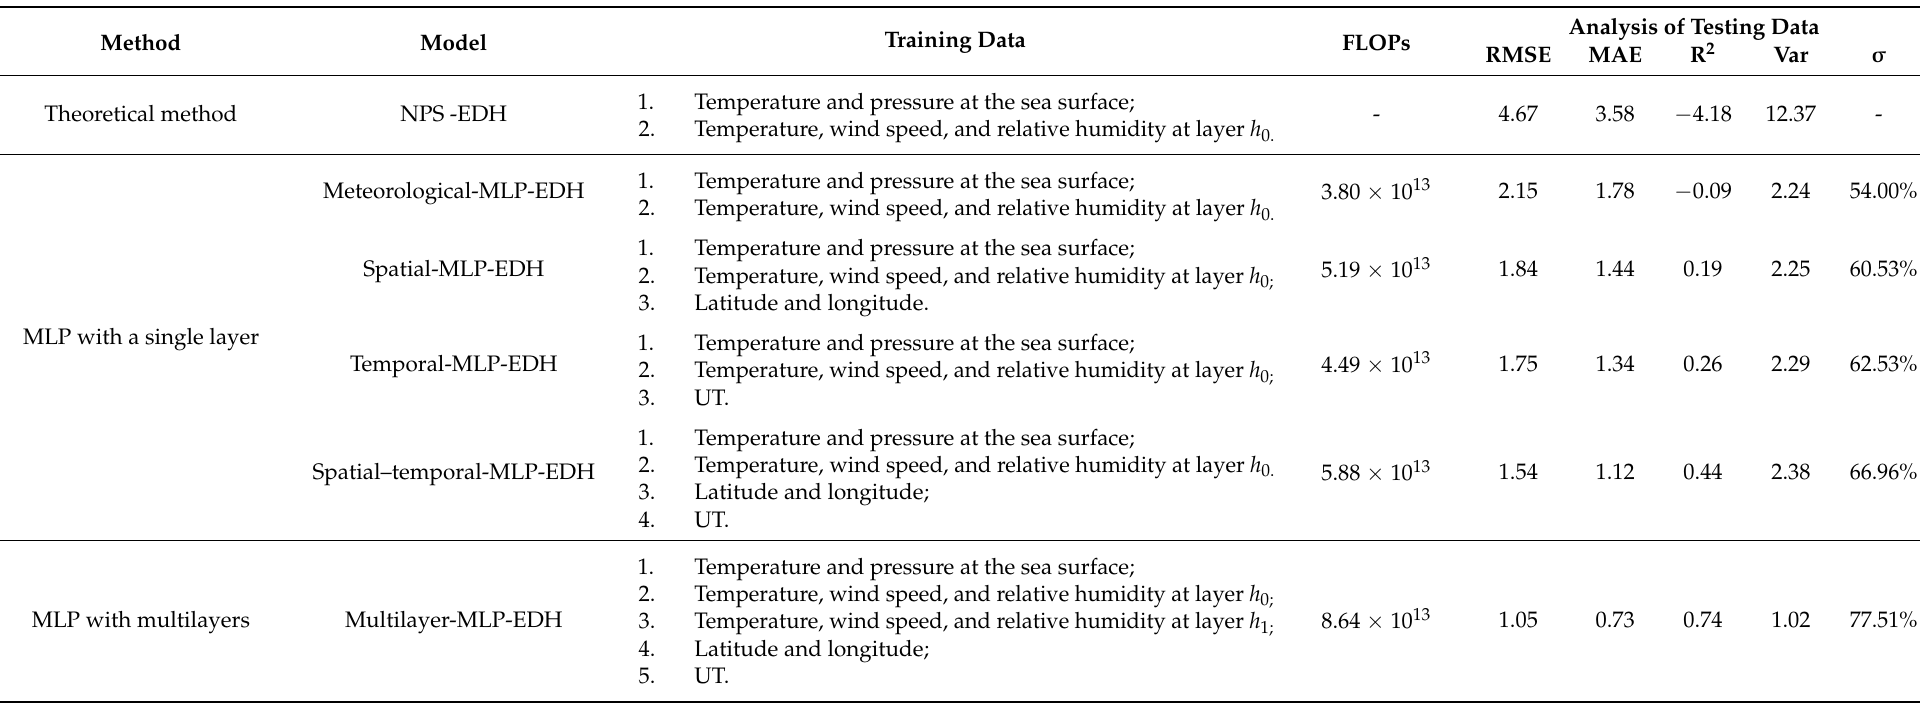
Table 5. Equation and characteristics of the performance